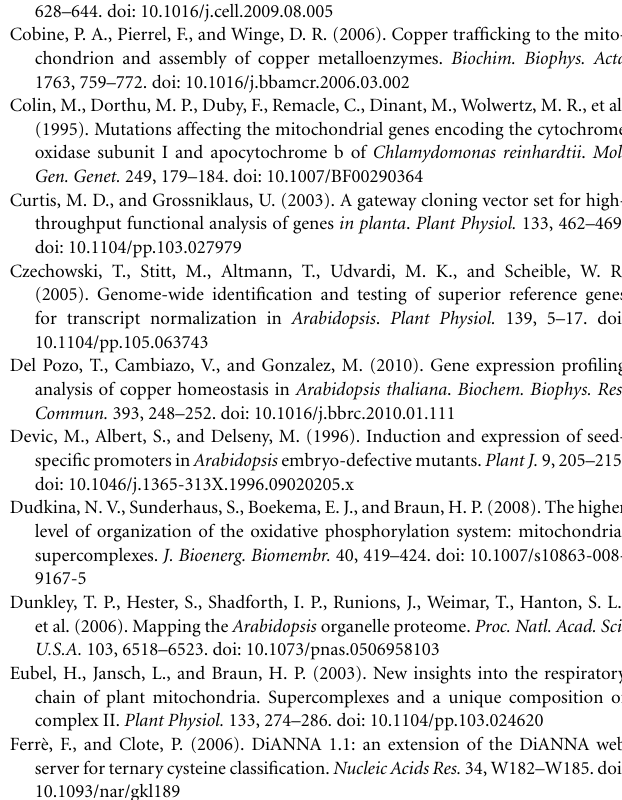
Supplementary Table 1 | Primer details. ∗ The attachment site sequences necessary for recombination were omitted. Only the gene-specific sequences are listed. Supplementary Figure 1 | Protein sequence alignment of SCO (HCC) proteins from plants: Arabidopsis thaliana (At), Oryza sativa subsp. japonica (Os), Brassica rapa subsp. pekinensis (Br), Glycine